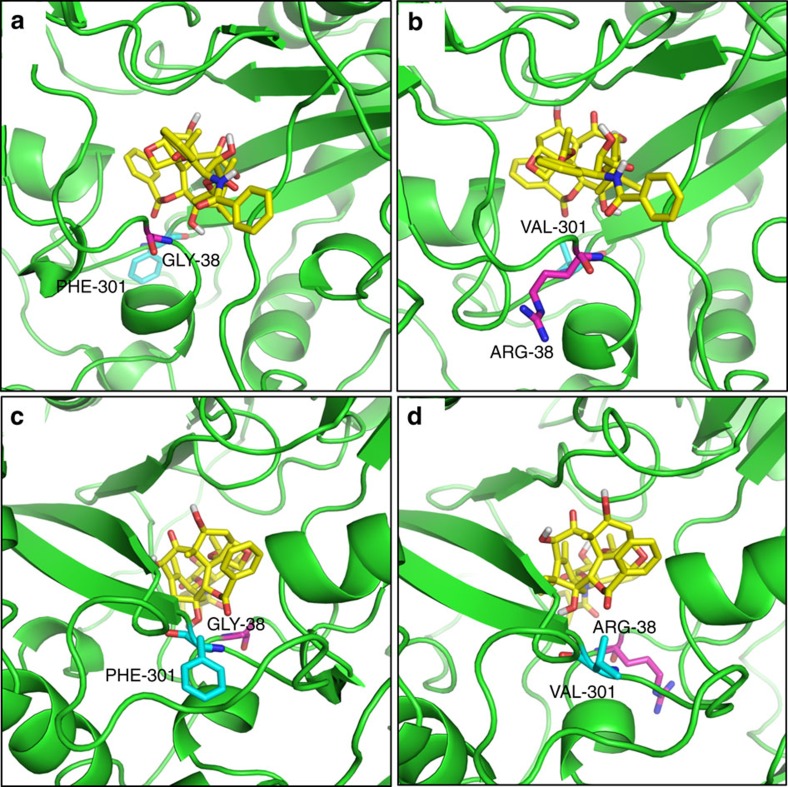
Molecular docking of DBAT and DBATG38R/F301V with DT.DT carbon atoms are coloured in yellow and oxygen atoms in red. The side chains of Gly38/Arg38 and Phe301/Val301 are also shown. Gly38/Arg38 carbon atoms are coloured in magenta and oxygen atoms in red. Phe301/Val301 carbon atoms are coloured in cyan and nitrogen atoms in blue. (a) Side view of DBAT with DT, showing Gly38; (b) Side view of DBATG38R/F301V with DT, showing Arg38. The increased hydrophilic properties of Arg38 compared to that of Gly38 favors the entry of both DT and 10-DAB substrates and leads to an elevated catalytic efficiency in the G38R mutant. (c) Opposite side view of DBAT with DT, showing Phe301. (d) Opposite side view of DBATG38R/F301V with DT, Showing Val301. Val301 maintains the hydrophobicity but has a smaller volume (98.71 Å3) than that of Phe (131.1 Å3), which leads to an increased catalytic efficiency in the F301V mutant due to the reduced hindrance.